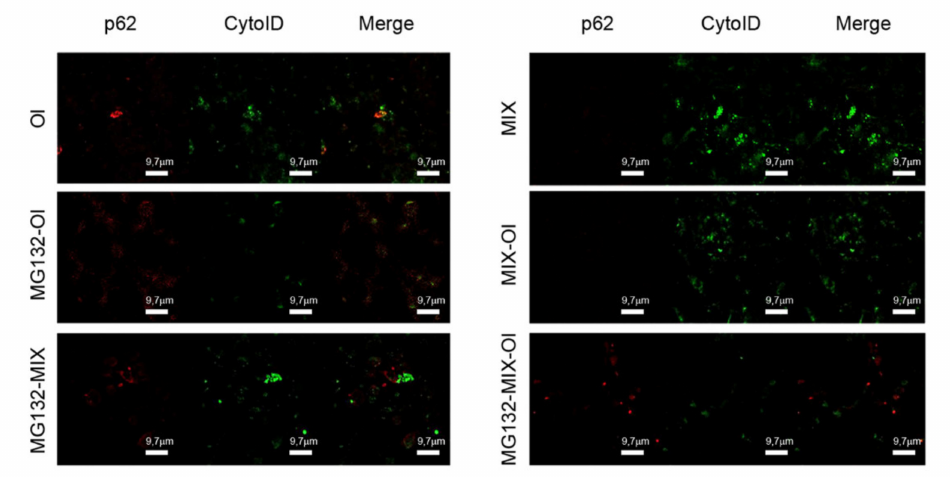
Figure 6. The MIX effects on p62 activity. Autophagosome formation in SH-SY5Y cells treated with (i.) oligomers (Ol) (2.5 µ M) for 24 h; (ii.) MIX (75 µ M) for 24 h and then with oligomers for further 24 h (MIX-Ol); (iii.) MG132 (5.0 µ M) for 6 h before different treatments. Autophagosomes were stained by Cyto-ID ® fluorescent dye (green fluorescence); p62 was stained with anti-p62 antibodies and Alexa 564-conjugated anti-mouse secondary antibodies (red